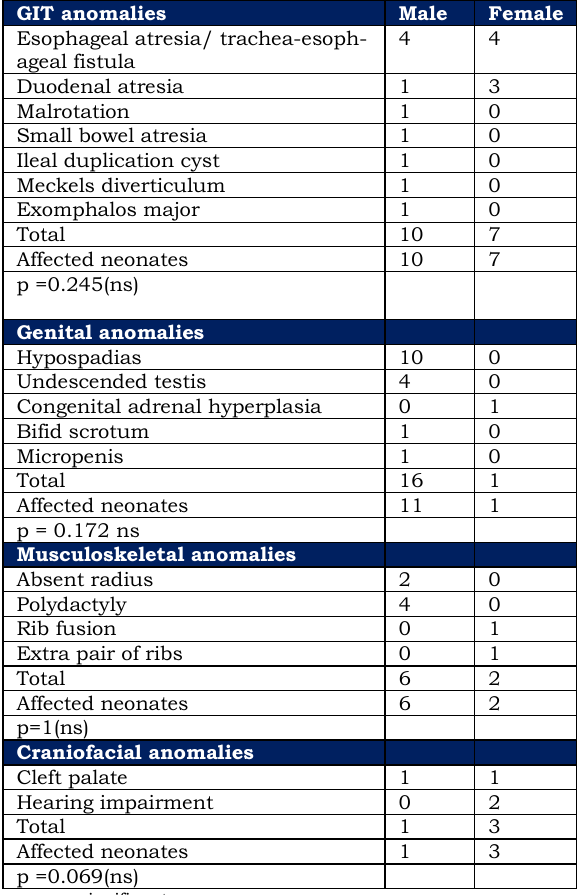
Table 4: Structural anomalies in the gastrointestinal, genital, musculoskeletal and craniofacial